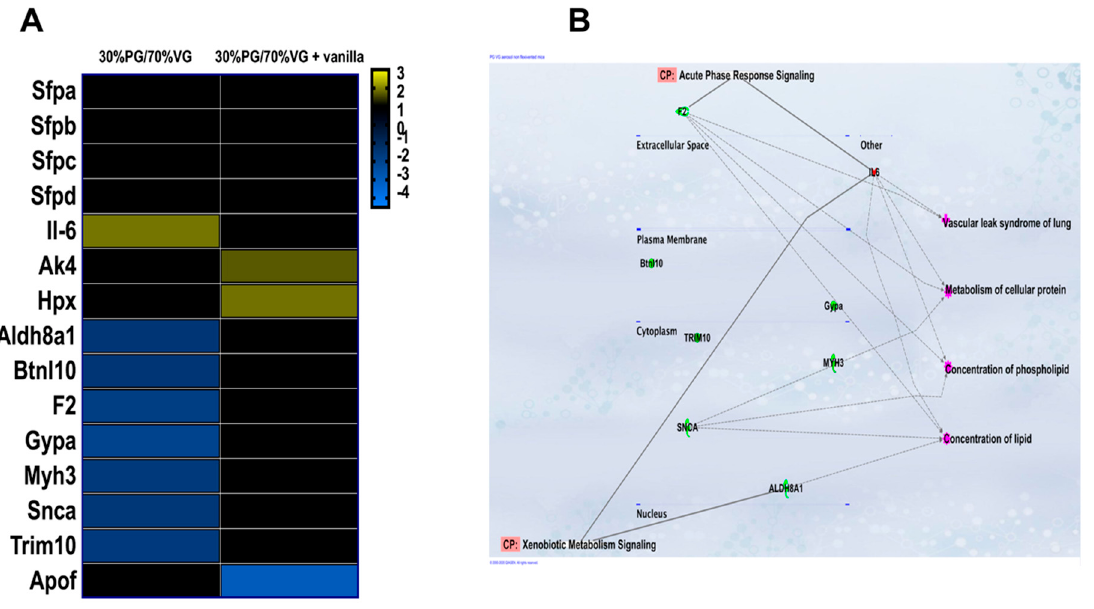
Figure 5. Inhalation of e-cig aerosols composed of 70%/30% VG/PG alone or with vanilla flavor dysregulates lung gene expression. ( A ) Heatmap demonstrating the expression of immunotoxicity related genes in lungs of mice. Black color denotes no difference in fold-change compared to air controls. ( B ) Ingenuity Pathway Analysis (IPA) gene networks associated canonical pathways and function. Data are expressed in fold-changes compared to air control group ( n = 4–6 mice per group). A greater than ±1.5-fold change is considered significant.